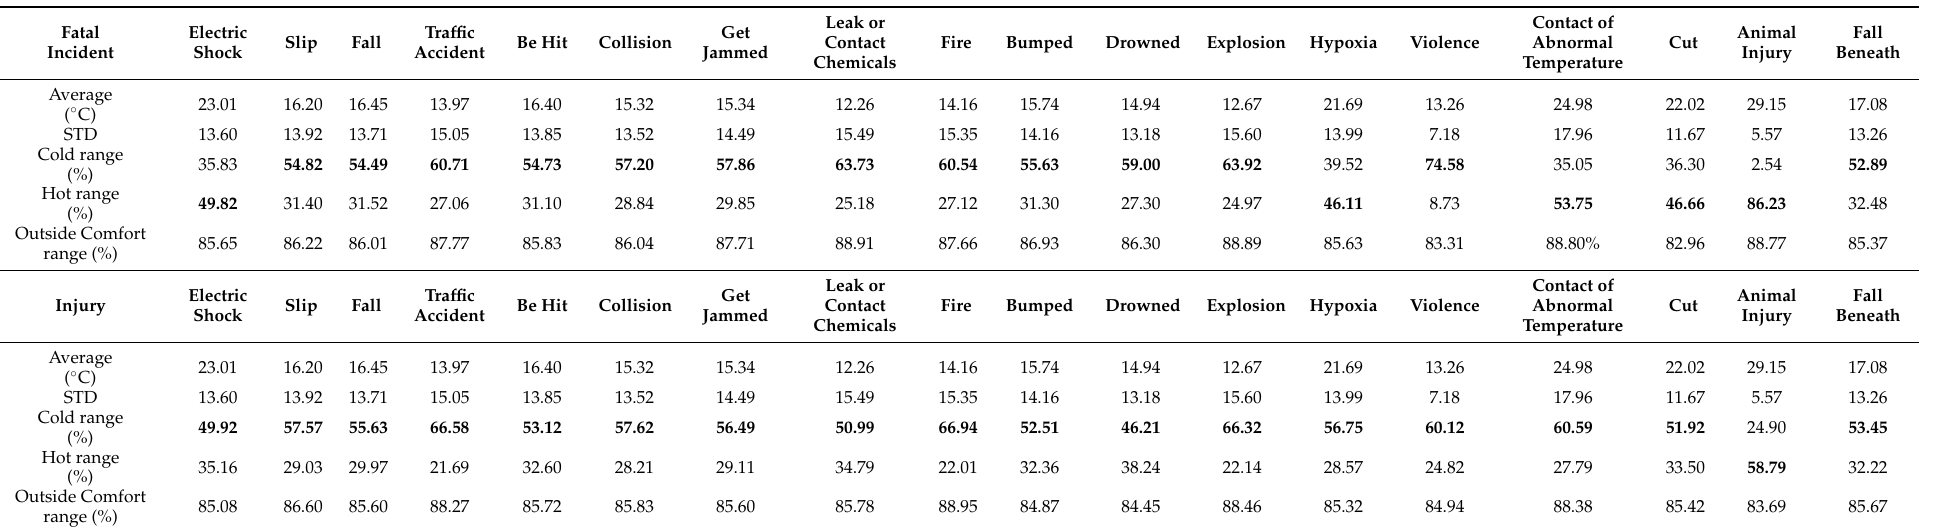
Table 8. Analysis of the probabilities of injury and fatal accidents in terms of the PET